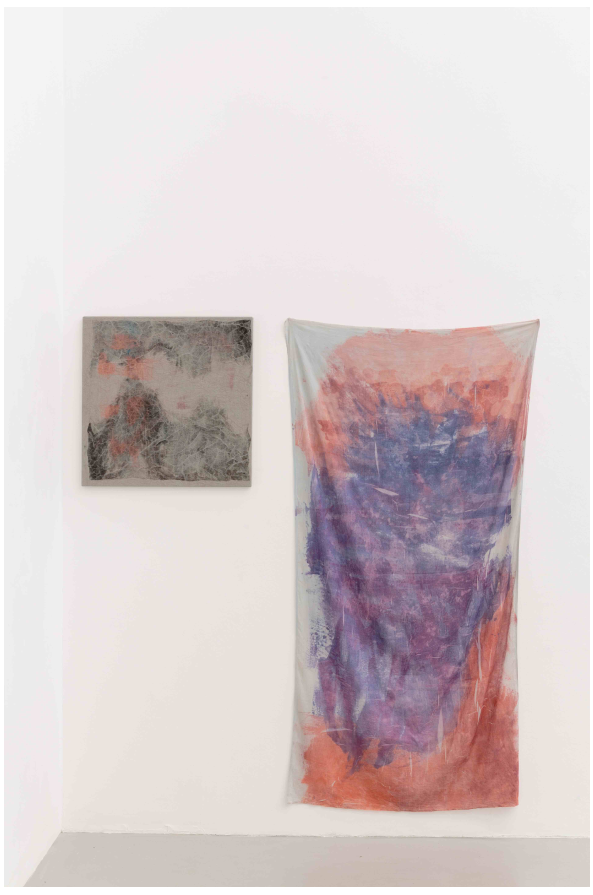
Figure 12: Sarah McNulty, Gram (Noon) , 2016, Sun-reactive paint on cotton, 100 x 200cm. Shrink (Noon) , 2016, Sun-reactive paint and ink on linen, 70 x